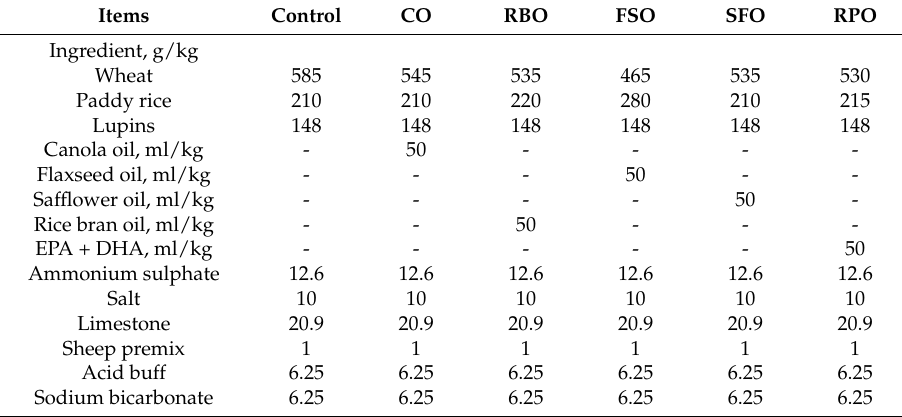
Table 1. Ingredient composition of the experimental pellets a